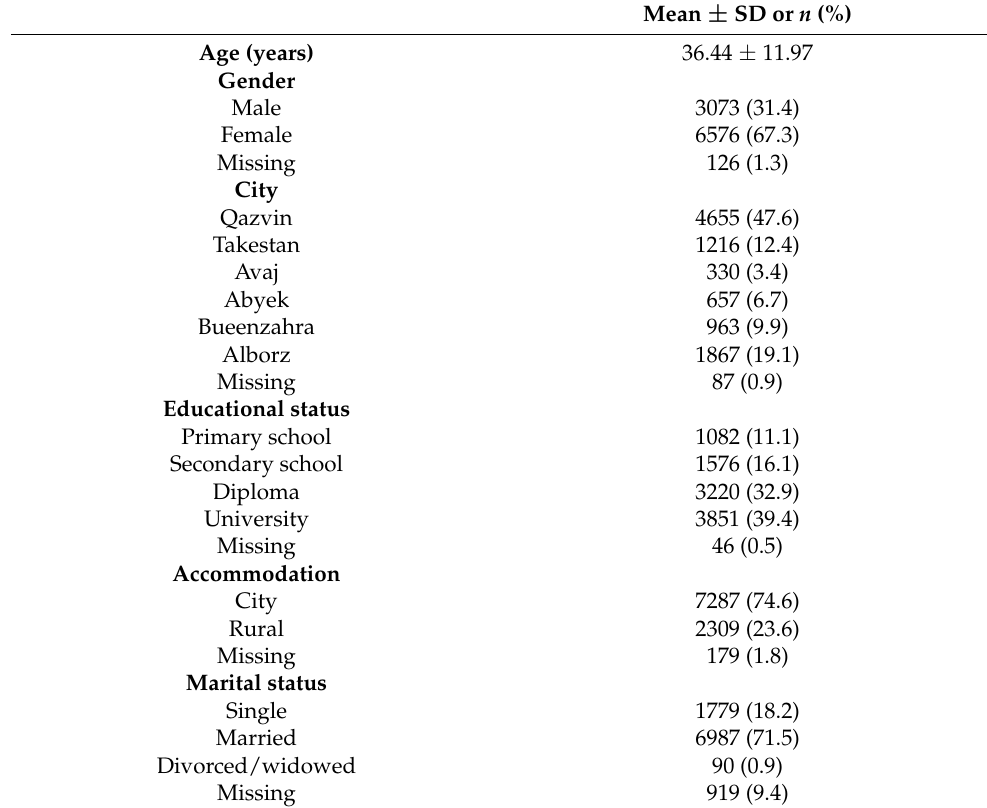
Table 1. Participant characteristics ( N =